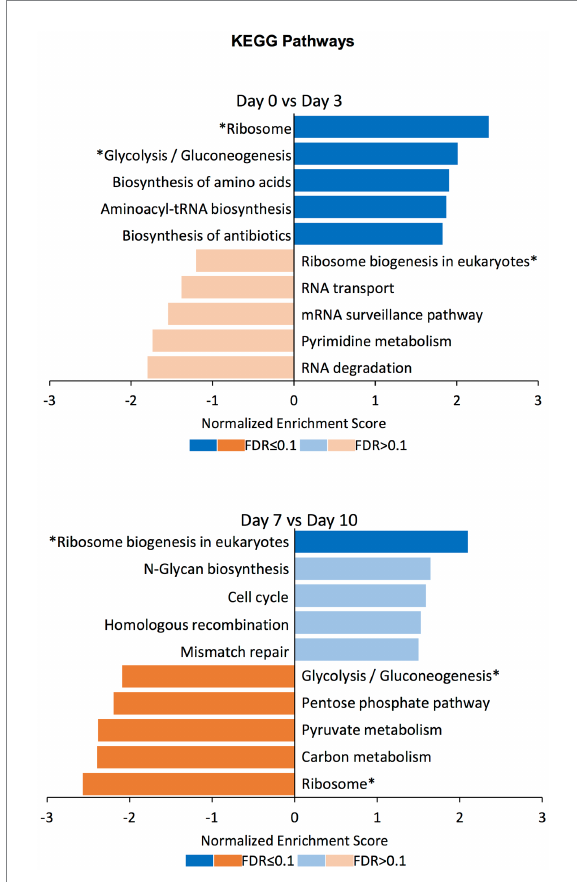
FIGURE 6 GSEA on differentially compacted loci on the KEGG Pathways domain. Gene Set Enrichment Analysis (GSEA) on the differentially available chromatin loci comparing Day0 vs. Day3 and Day7 vs. Day10 (the two comparisons displaying most of the significant changes genome-wide). The bar plots show the normalized enrichment score for the top5 gene sets with increased (blue) and decreased (orange) chromatin availability in the latter time point. Dark colors indicate an FDR ≤ 0.1 for the indicated gene set, while pale colors indicate an FDR > 0.1. Gene sets that have been identified as increased in the Day0 vs. Day3 comparison and decreased in the Day7 vs. Day10 comparison (or vice versa) are indicated with an asterisk